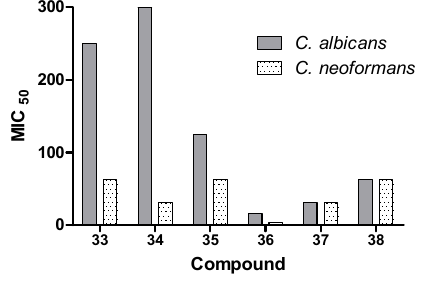
Figure 3. Comparison of MIC 50 values of each compound of the (ii.2) sub-series against C. albicans or C. neoformans.